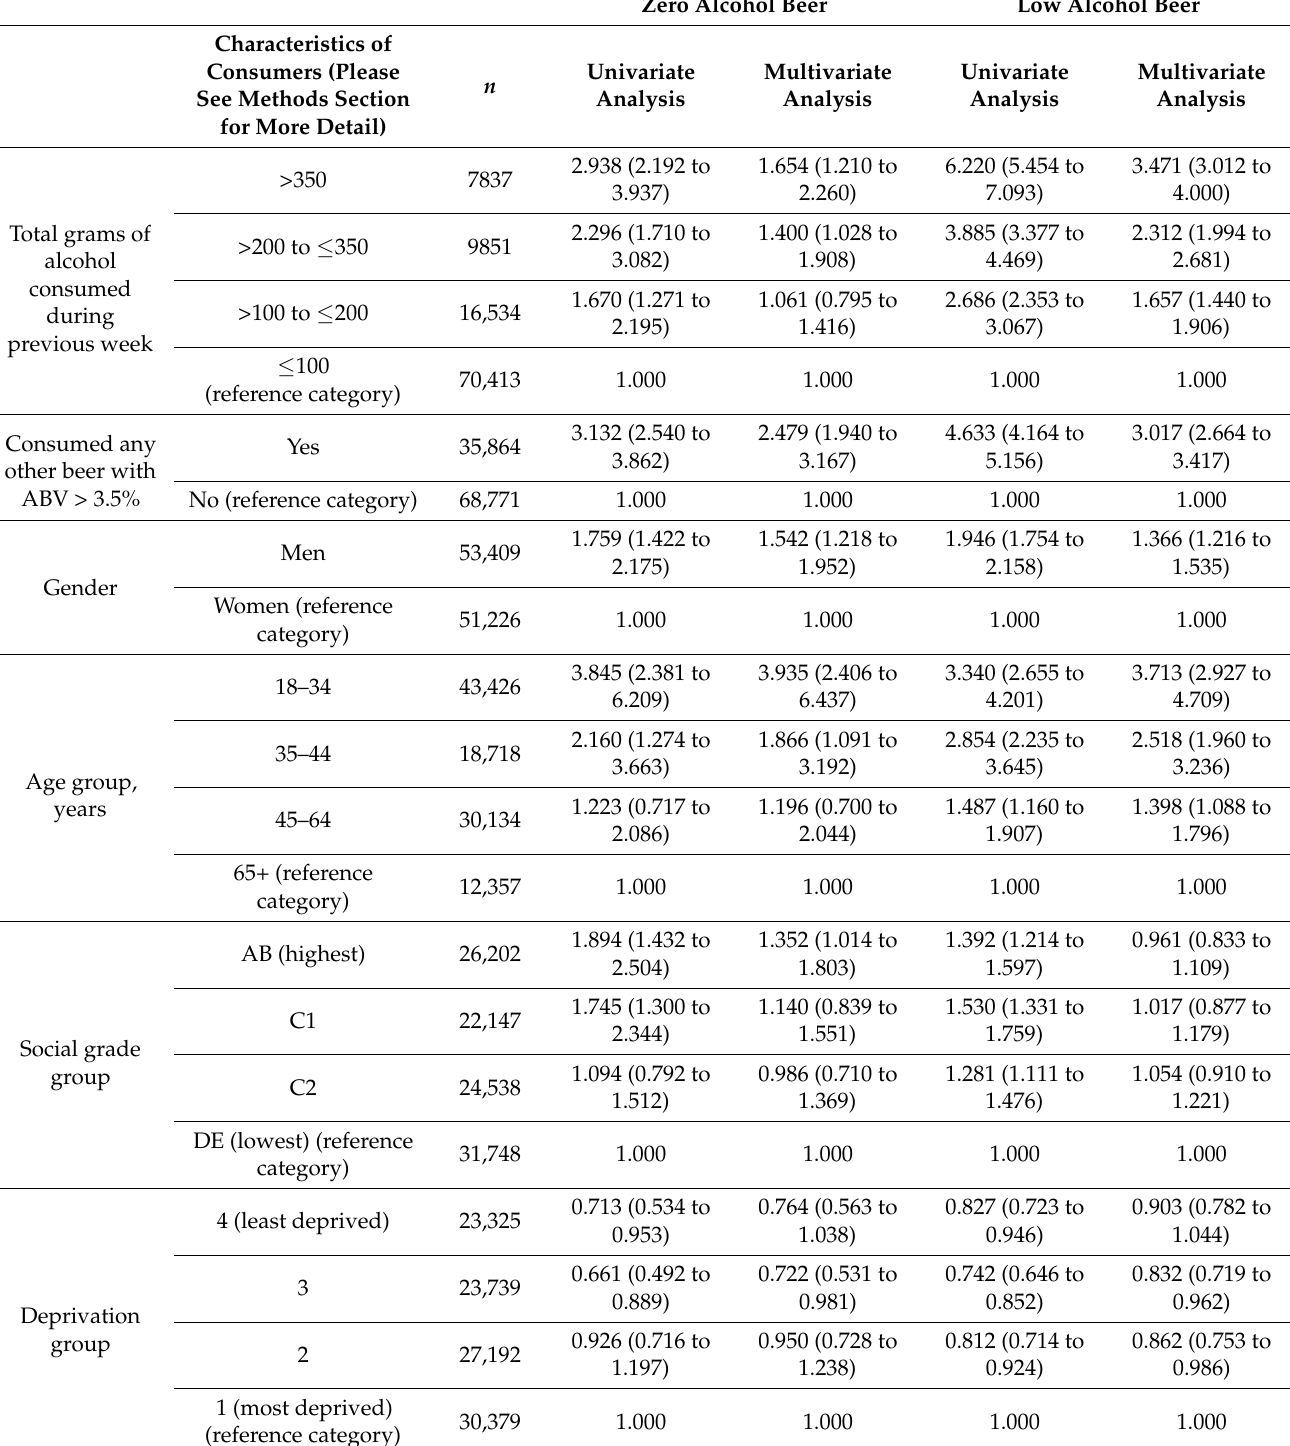
Table 2 gives the odds ratios (95% confidence intervals) for a respondent consuming at least one zero alcohol beer and at least one low alcohol beer during the previous week by respondent characteristics. Table 2. Analysis at level of each respondent; odds ratios (OR) (95% confidence intervals) for any consumption of zero alcohol beer (ABV = 0.0%) or low alcohol beer (ABV > 0.0% and ≤ 3.5%) during previous week by respondent socio- demographic characteristics. In bold: 95% confidence interval does not cross